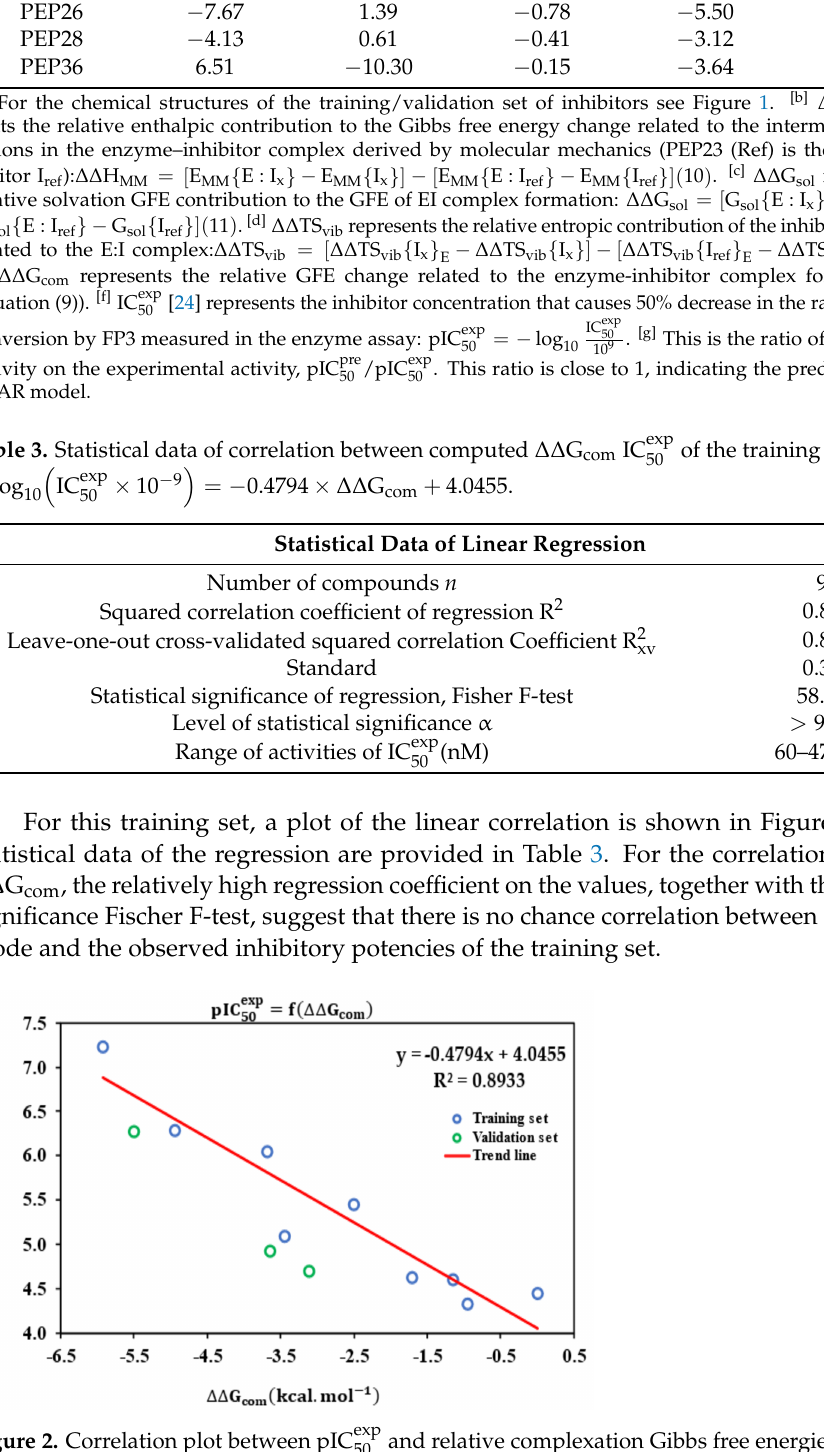
and relative complexation Gibbs free energies ∆∆ G com of 50